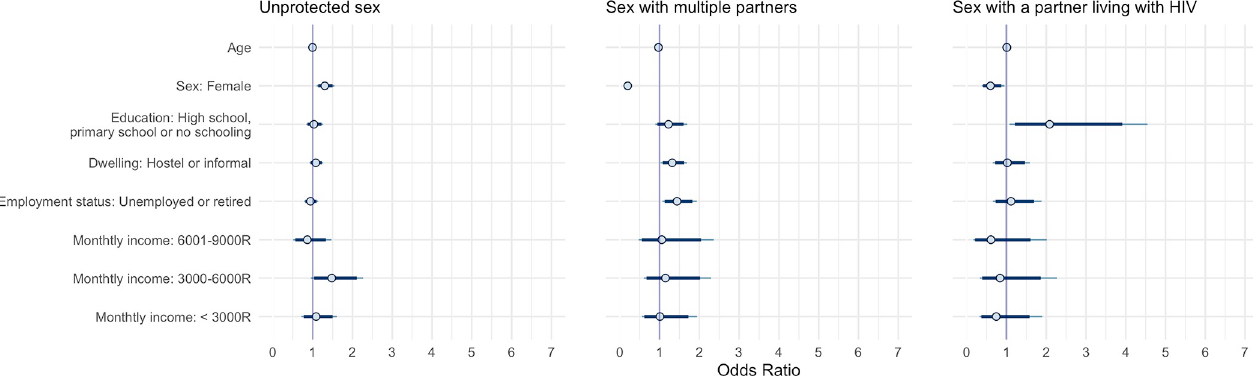
Fig 2. Bayesian logistic regression model posterior intervals of adjusted odds ratios of the impact of socioeconomic factors on select behavioural factors. Points represent the posterior medians, thick segments represent the 89% credible intervals and thin segments represent the 95% intervals of the adjusted odds